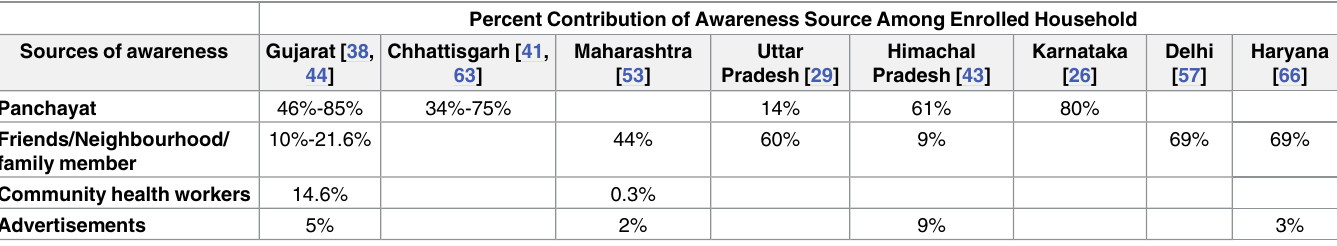
Table 4. Source of awareness on publicly sponsored health insurance schemes in Indian States.